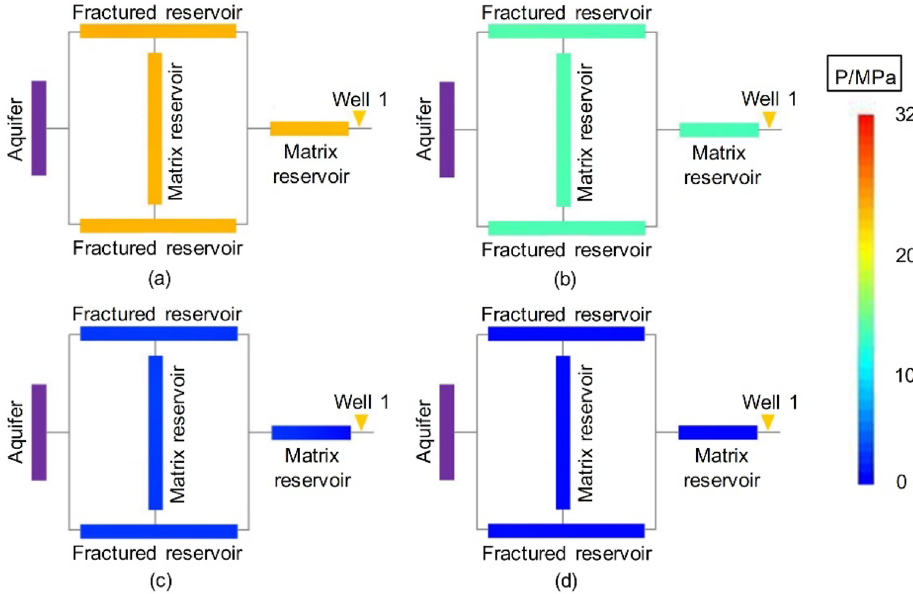
Figure 7. Pressure distributions at different stages of Experiment 4-2: ( a ) early stage of production – 10 min, ( b ) early stage of production—30 min, ( c ) end of the stabilized period—55 min, and ( d ) production halts— 88 min.